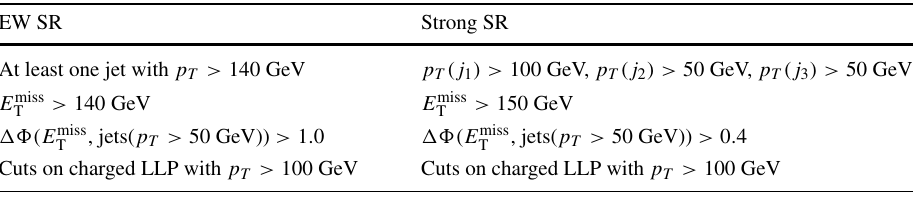
for a chargino produced in direct electroweak production